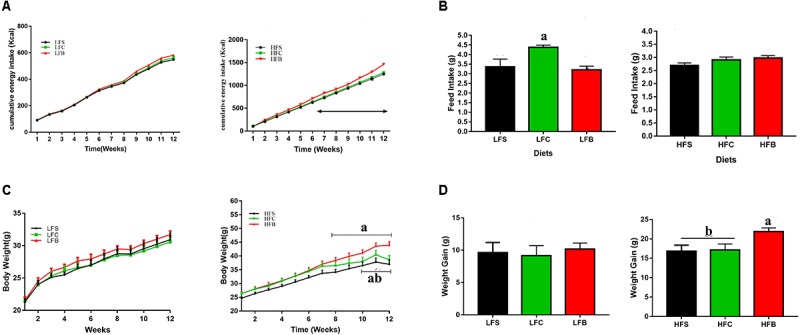
Feed intake and weight gain of mice in response to different diets. (A) Cumulative energy intake. Arrow indicates significant increase in energy intake of HFB-fed mice (P < 0.05). (B) Daily feed intake. (C) Growth curve. Arrow indicates significant difference (P < 0.05). (D) Total weight gain. The data represent group means (n = 10/group) ± SEM. Different letters denote statistical significance (P < 0.05).